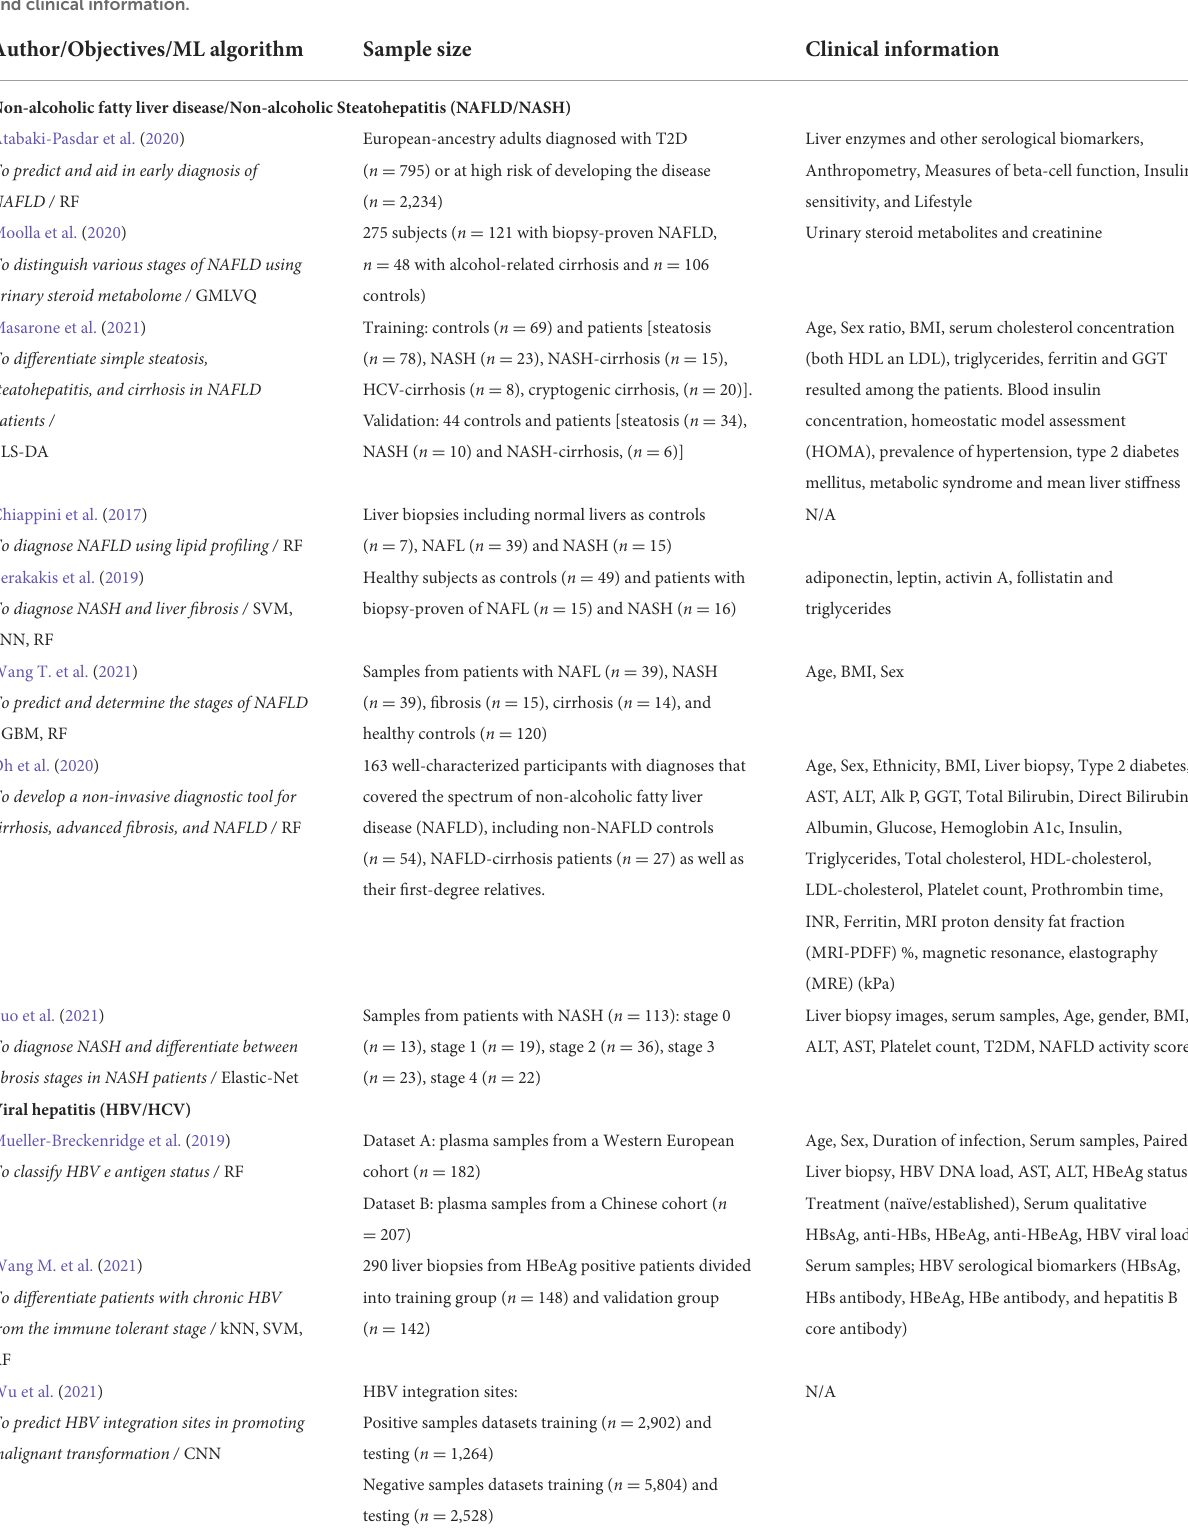
TABLE 1 Summary of the studies included in this review classified by the liver diseases, with details on the objectives, ML algorithm used, sample and clinical